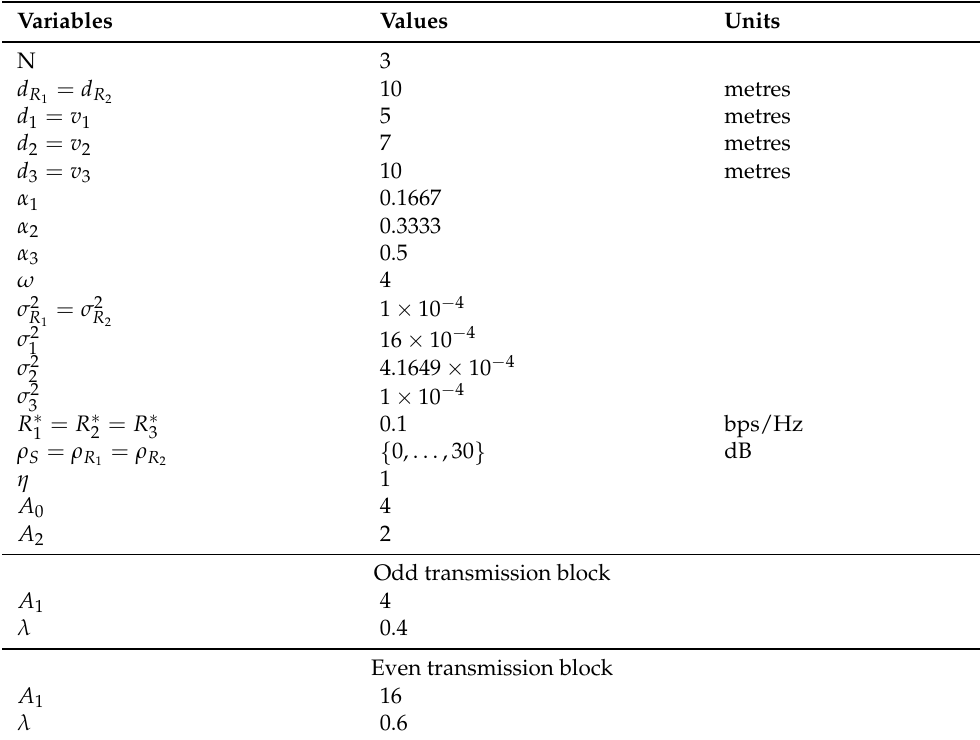
Table 1. Table of parameters.